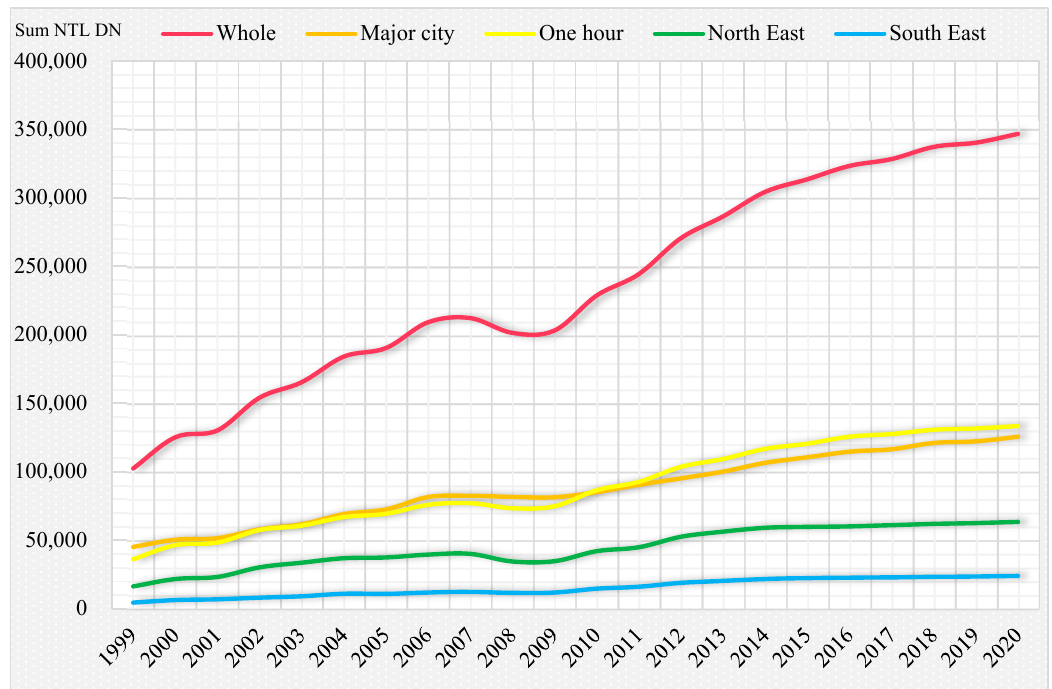
Figure 11. NTL sum from 1999 to 2020 for Chongqing and four sub-city regions.